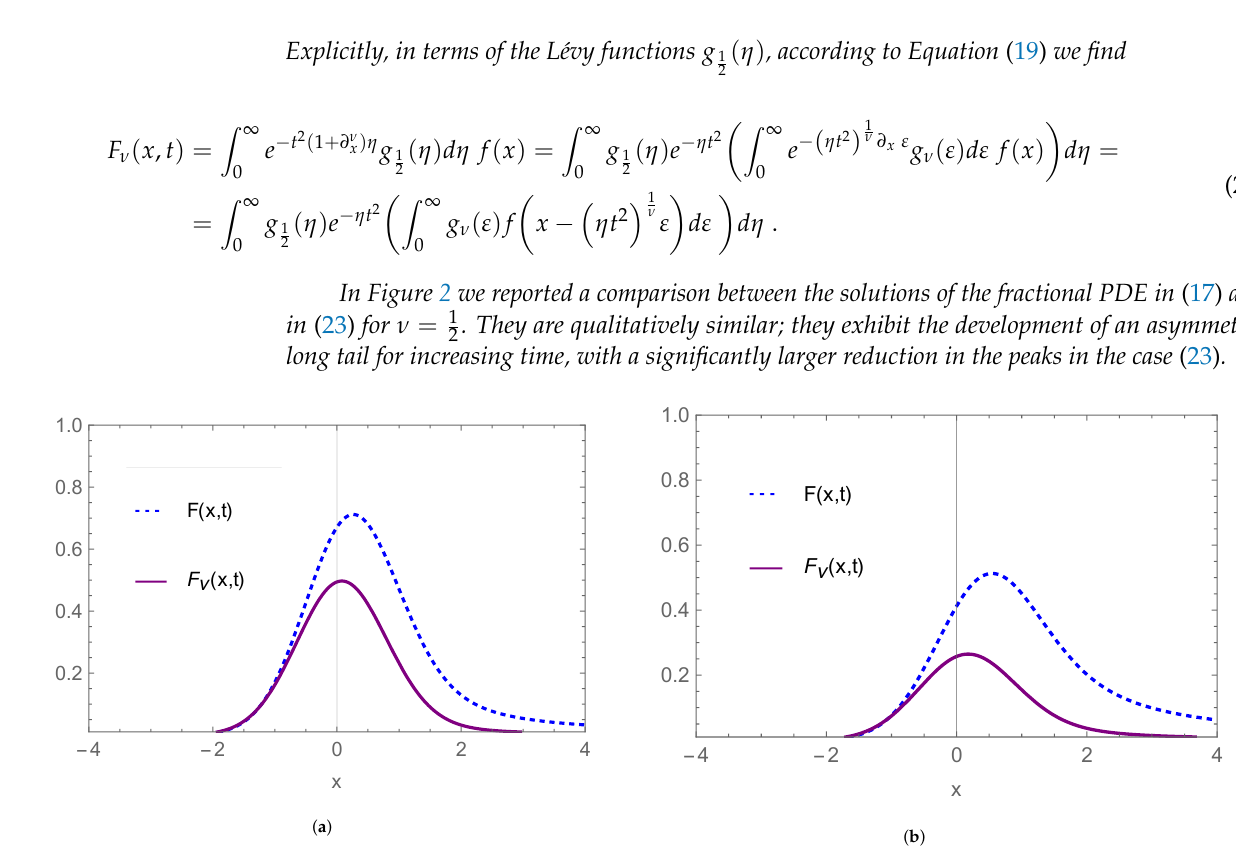
Figure 2. Comparison between the solutions of Equations (17) and (23) for ν = 1 ( b ) t =